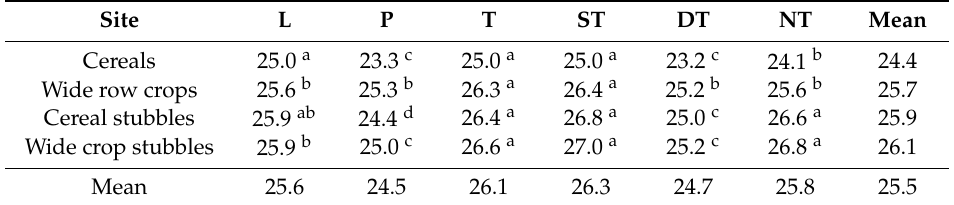
Table 3. Soil water content (SWC, w / w − 1 ) at four di ff erent type of seasons and di ff erent crop sites.